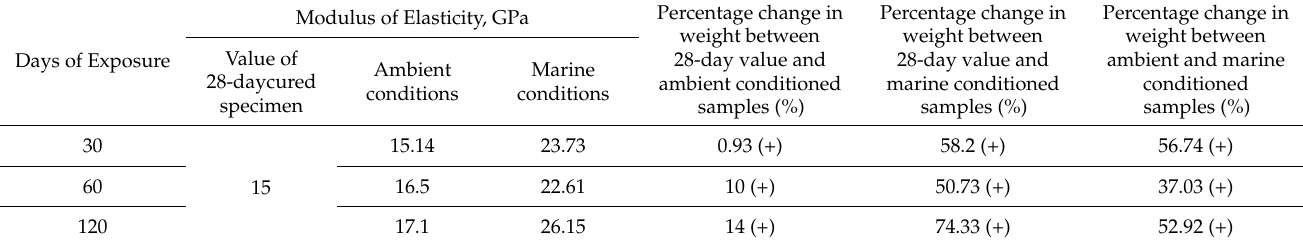
Table 8. Comparison of modulus of elasticity under ambient and marine exposure conditions.